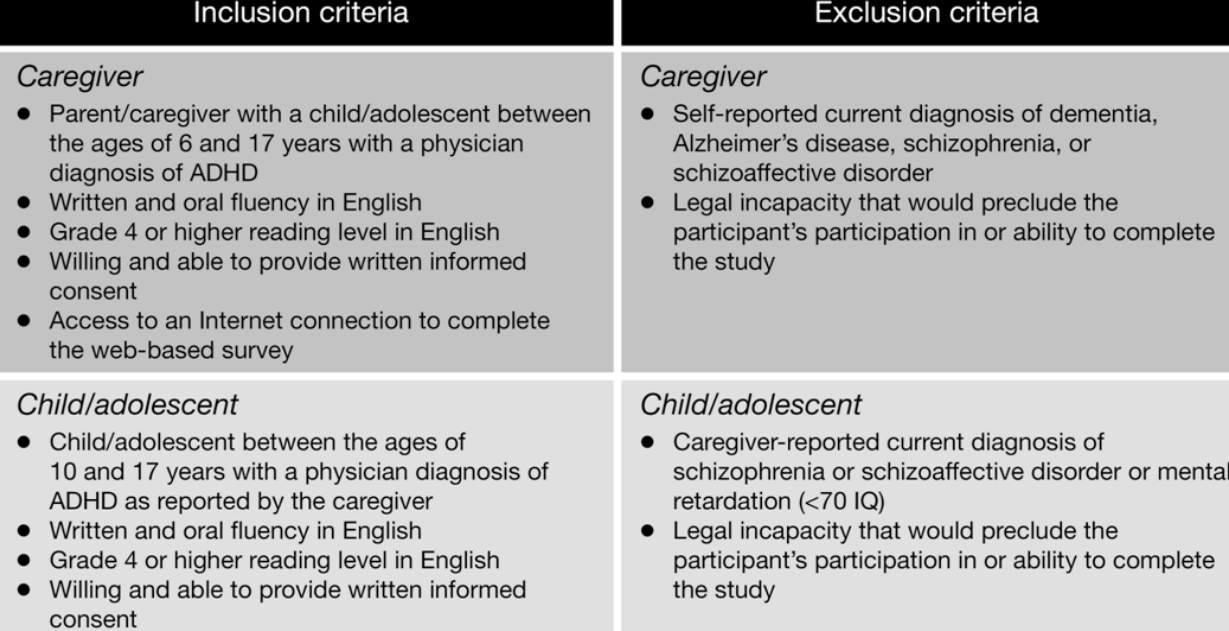
ADHD: attention-deficit/hyperactivity disorder; IQ: intelligence